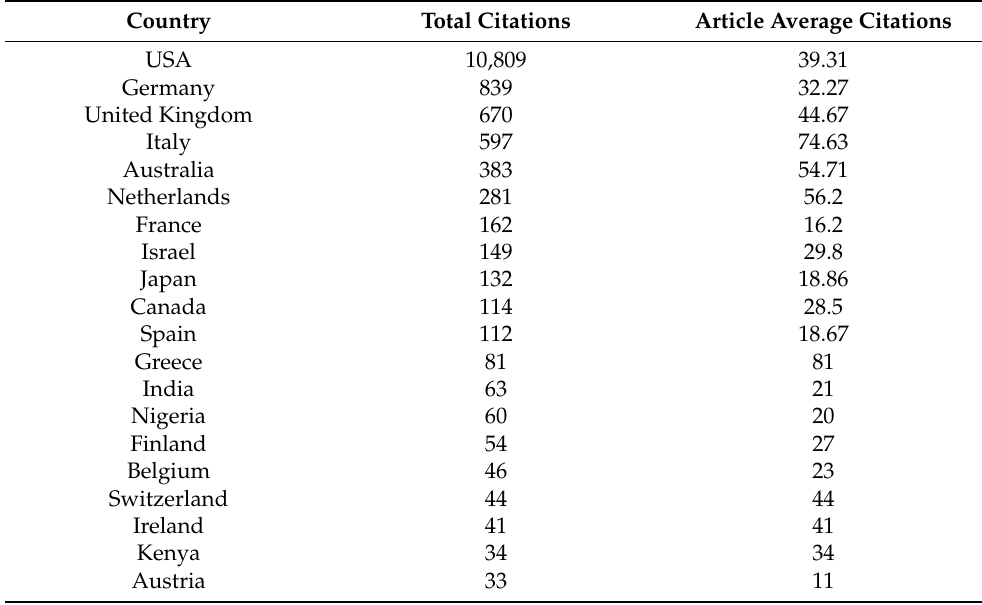
Table 5. Countries with the highest total and average article citations.